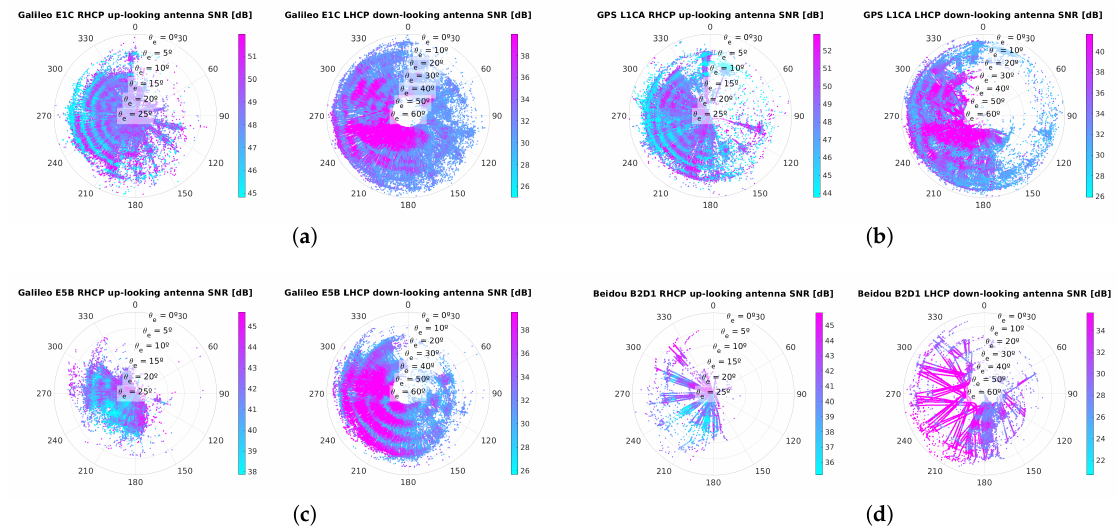
Figure 9. Radar plot of the SNR for ( a ) Galileo E1C, ( b ) GPS L1 C / A, ( c ) Galileo E5b signal, and ( d )